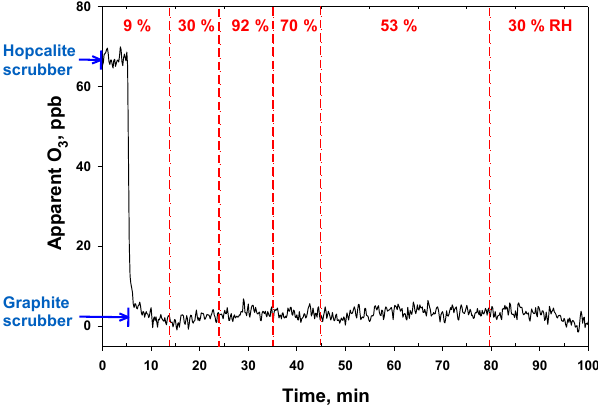
Figure 9. Apparent ozone observed upon addition of ∼ 1.3ppm of p -xylene to ozone-free air. Initially, the ozone analyzer was equipped with the standard Hopcalite scrubber (apparent O 3 con- centration = 67ppb). The Hopcalite was replaced with the heated graphite scrubber at time = 5min. Over the next 95min, the rela- tive humidity of the air was varied as designated by the red vertical dashed